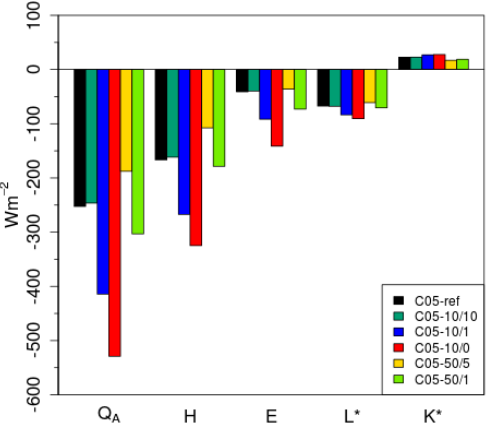
Figure 9. Temporal means of the energy balance Q A and its com- ponents ( H is sensible heat flux, E is latent heat flux, L ∗ is net longwave, and K ∗ net shortwave radiation) averaged over polynya grid boxes for the winter period 2007/2008. For the averaging at least nine grid boxes in the model domain had to be polynyas to include them in the